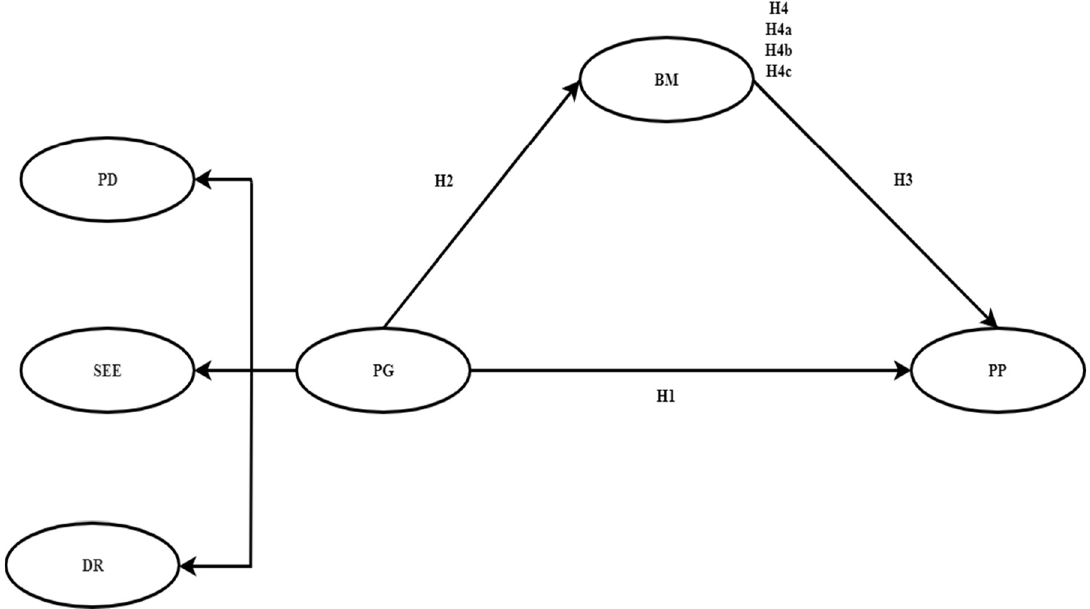
Figure 1. Conceptual